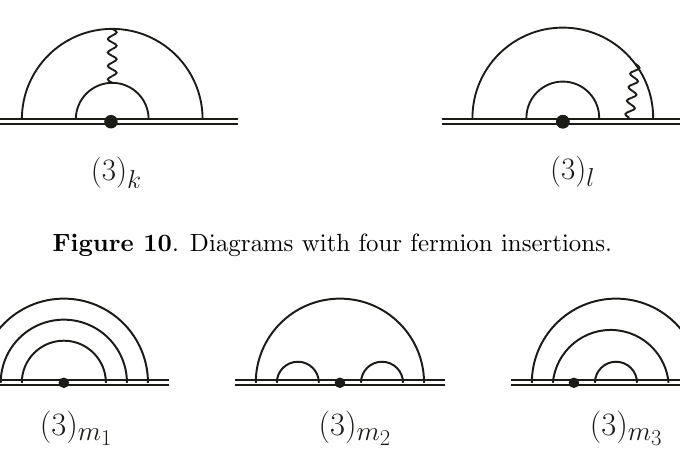
Figure 9 . Diagrams with two fermion insertions. Grey and black bullets represent one and two loops self-energy corrections, respectively.